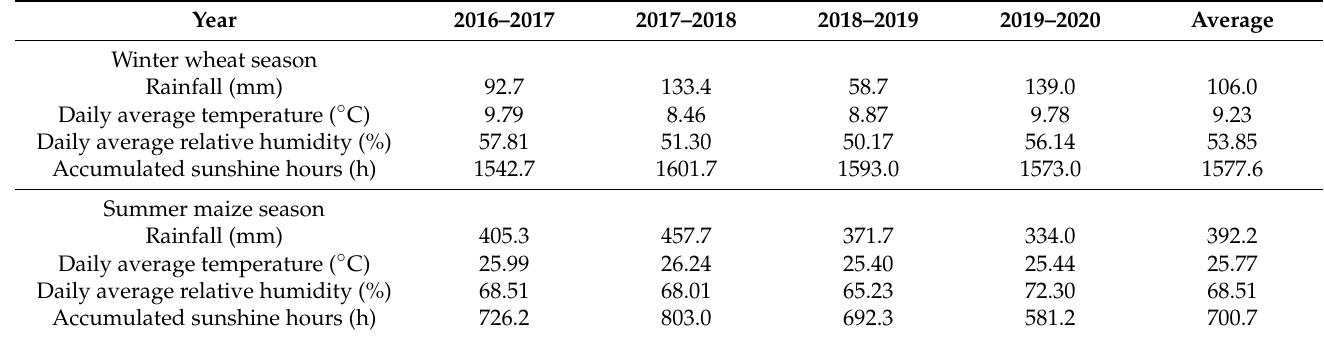
Table 3. Seasonal meteorological factors at the experimental site from 2016 to